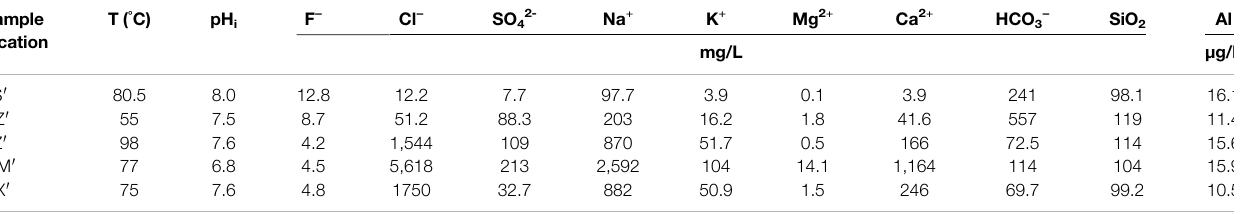
TABLE 4 | Water chemistry of typical samples for FS, HZ, XZ, MM geothermal fi elds in Guangdong province and GX geothermal fi eld in Hainan province. Sample